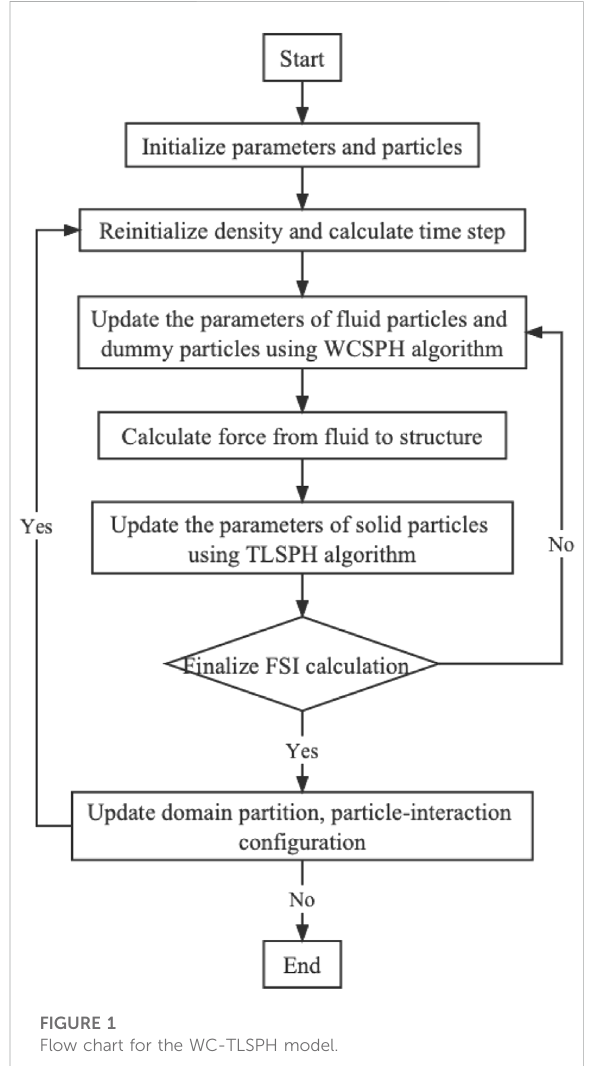
Flow chart for the WC-TLSPH